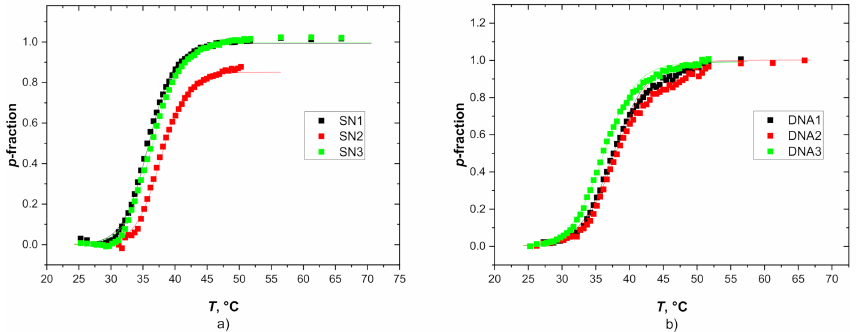
Figure 7. Temperature dependences of p -fraction as determined from PDEAAm CH 3 signal in ( a ) SN and ( b ) DNA hydrogels. Experimental points are fitted according to Equation